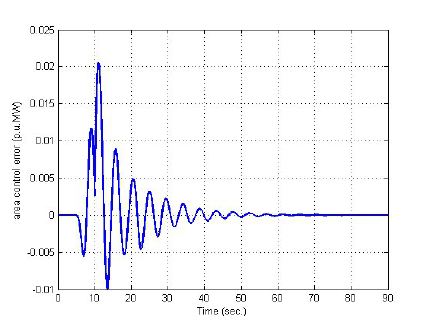
Fig. 16: ACE in control area 2 (Case